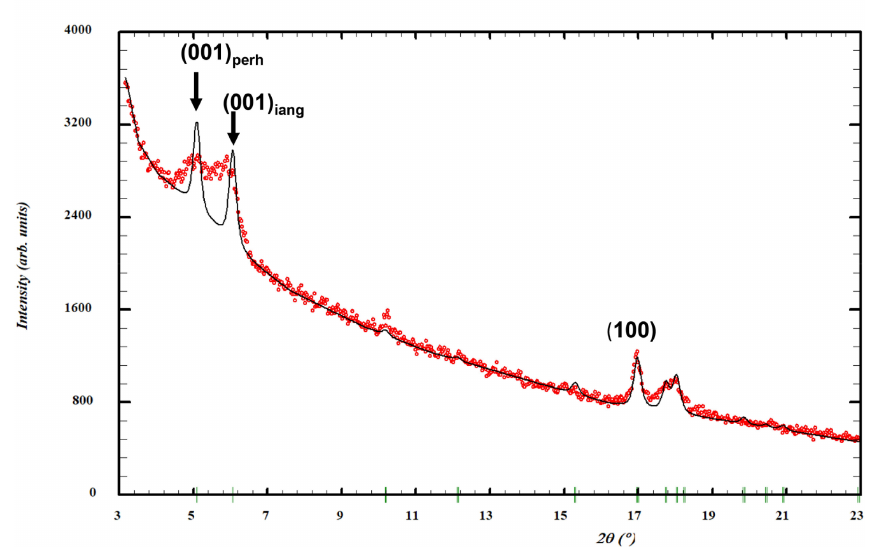
Figure 10. Low-angle region of a PXRD pattern for specimen IGC112. Red dots represent experimental values, and the black line represents a Rietveld-fitted profile with a two-phase mixture of iangreyite plus perhamite. The refined peak width matches the experimental width for the (100) reflection but is too narrow for the (001) reflections.